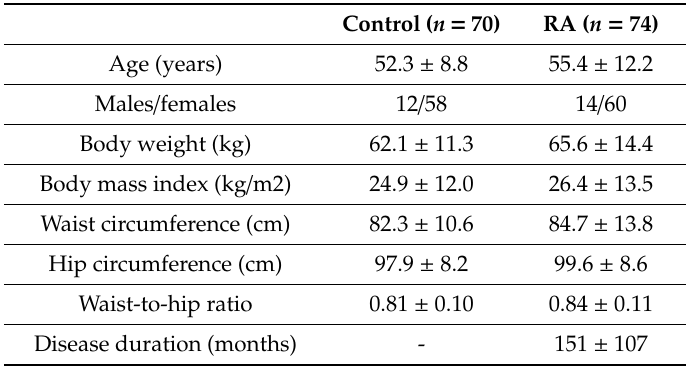
Table 1. Characteristics of RA patients and control subjects.